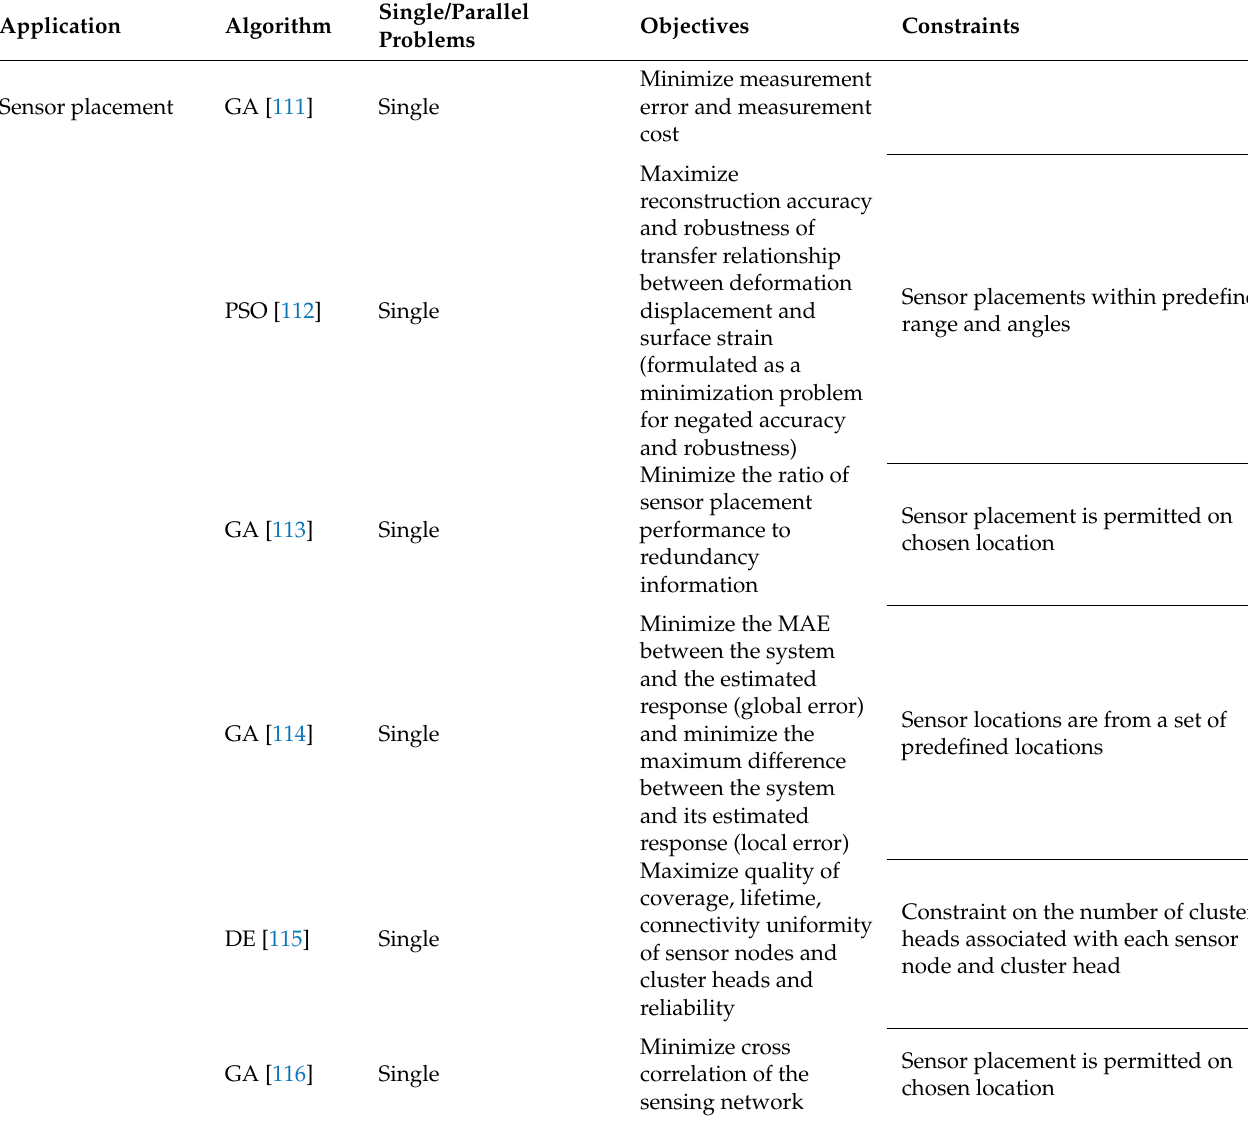
Table 13. Optimization in Smart